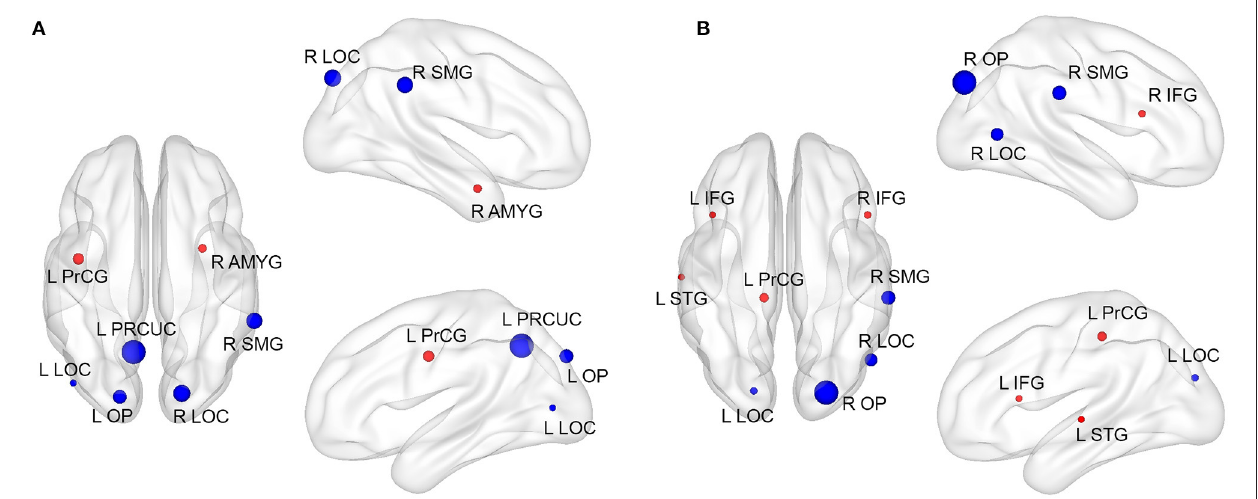
FIGURE 2 | Significant local altered connectivity was observed in left- and right-sided stroke patients. Compared with HCs, the location and cluster size of regions with increased (red) and decreased (blue) local degree was depicted in (A) for the left-sided stroke patients, (B) for right-sided stroke patients. Red and blue nodes represented where nodal degree of stroke patients was greater and less than HCs, respectively. The size of the node represents cluster size. Significant level was set at p < 0.05 after multiple comparison corrections. left-sided stroke exhibited significantly increased nodal degree in the left precentral gyrus (L PrCG) and right amygdala (R AMYG), and the decreased nodal degree in the left precuneous L LOC ( Table 3A ; Figure 2A ). Patients with right-side